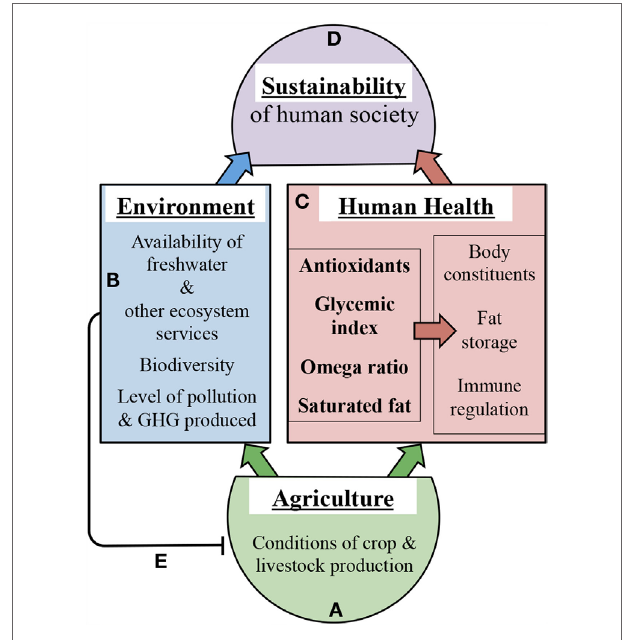
FiguRe 4 | Schematic depiction of selected examples of how agriculture (a) affects environment (b), human health (C), and thereby sustainability outcomes (D) . The left box in (C) depicts crop and livestock composition with respect to the four selected nutritional features listed in Table 1 that are highly dependent on production conditions. The right box in (C) features human health outcomes impacted by crop and livestock composition. (b) features environmental outcomes impacted by crop and livestock production conditions. Line (e) depicts the negative feedback of intensive methods in modern agriculture on the health of agricultural systems and future food production. GHG, greenhouse gas. The links depicted here are intended to serve as examples rather than as an exhaustive